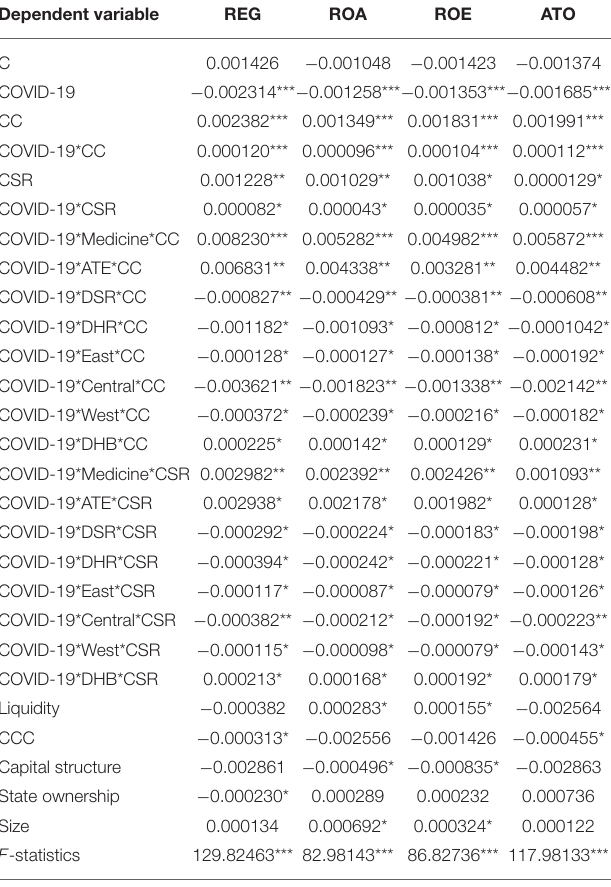
TABLE 10 | Generalized linear regression with CR and CSR. TABLE 11 | Generalized linear regression in state-ownership list companies. Dependent